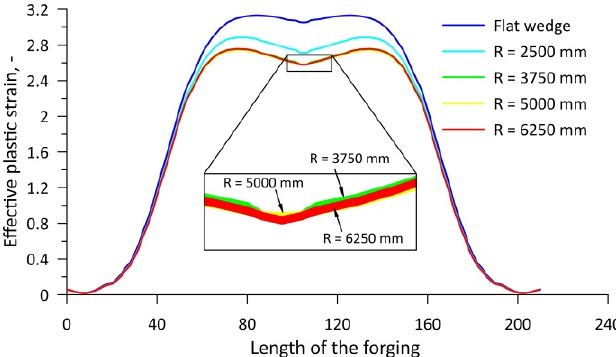
Figure 19. Distribution of the numerical values of the effective plastic strain along the central axis of the forgings.